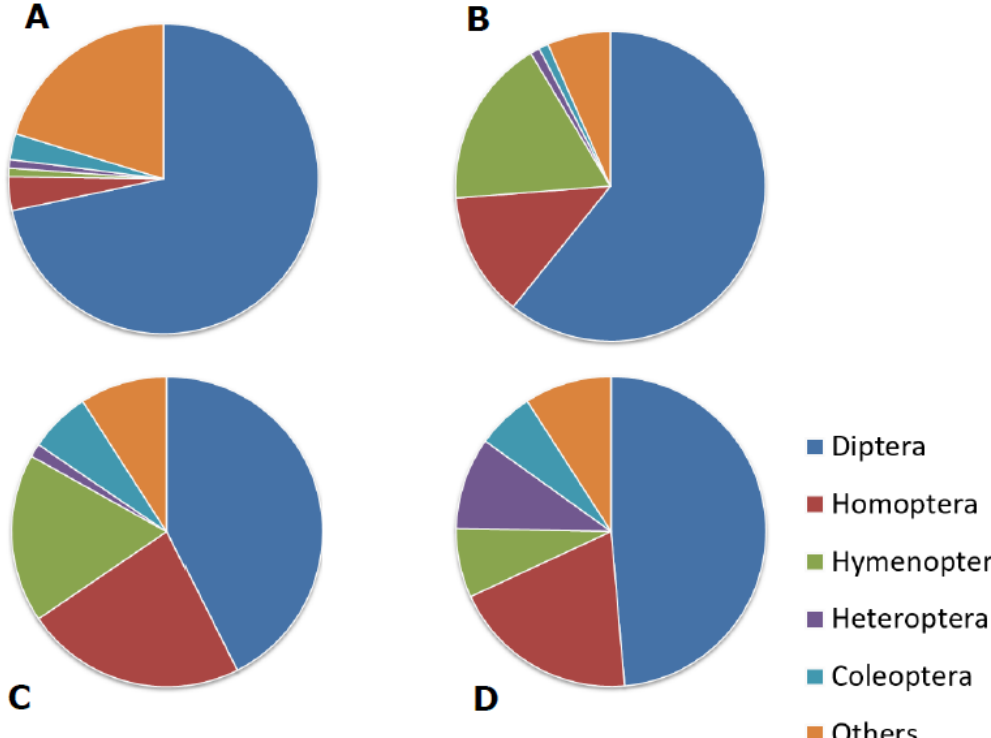
Figure 1. Prey composition (% by number) of the garden orb-weaver Araneus diadematus based on four field studies: ( A ) oat field near Zurich, Switzerland [21]; ( B ) fallow grassland near Zurich, Switzerland [21]; ( C ) fallow grassland near Jena, Germany [18]; ( D ) maize field margin near Munich [19]. Homoptera refers primarily to alate aphids.